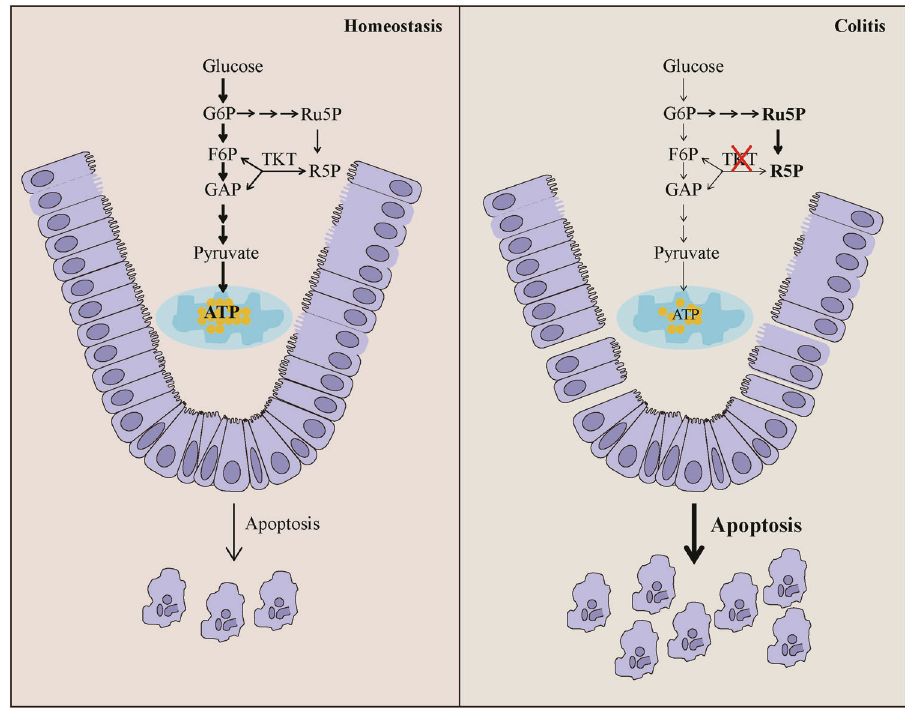
Fig. 8 Graphical model. TKT serves as a safeguard to maintain intestinal homeostasis and barrier function by regulating ATP production and